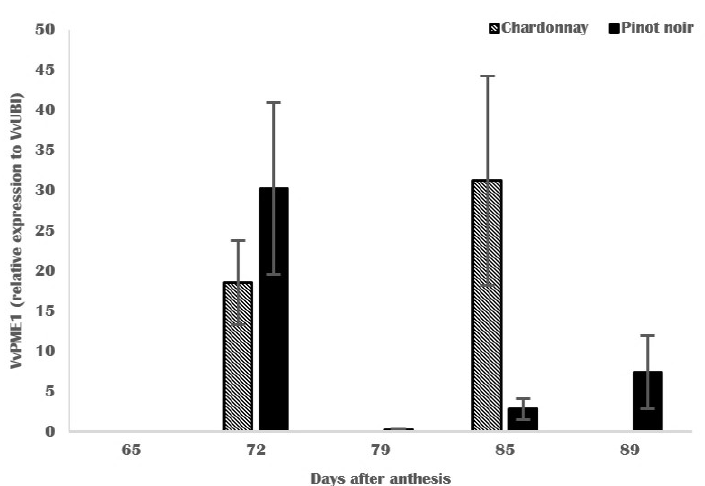
Figure 10. Gene expression of VvPME1 in Pinot noir and Chardonnay skins during ripening. Means of 3 replications ± SD.